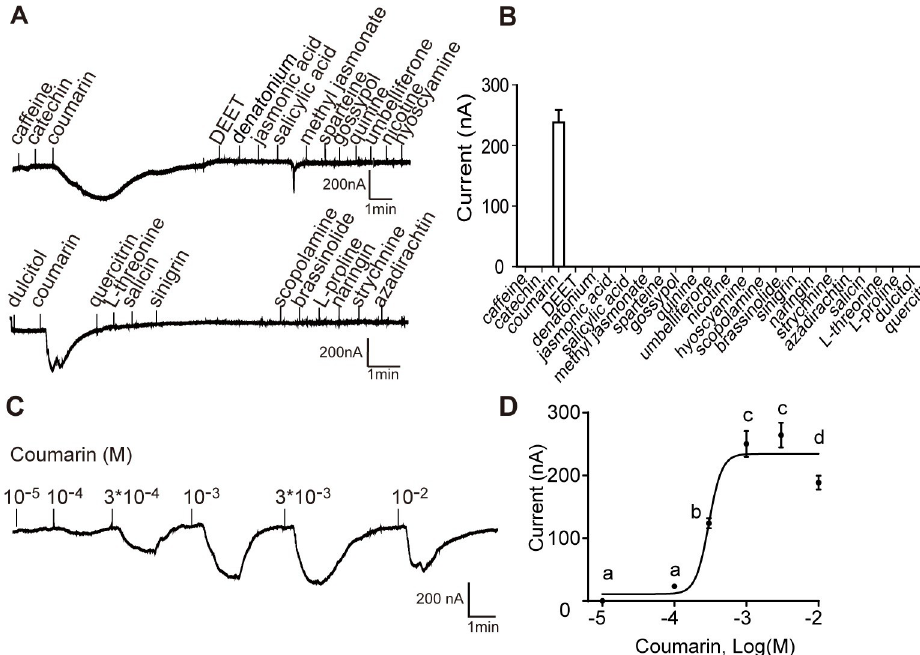
Fig 2. Functional analysis of Helicoverpa armigera Gr180 in Xenopus oocytes. ( A ) Representative inward current responses of Xenopus oocytes expressing Gr180 in response to compounds. ( B ) Response profiles of Xenopus oocytes expressing Gr180 in response to compounds (n = 8–14). ( C ) Representative inward current responses of Xenopus oocytes expressing Gr180 in response to coumarin at a range of concentrations. ( D ) Dose responses of Xenopus oocytes expressing Gr180 to coumarin (n = 8). Data are mean ± SEM. Different letters are significantly different at p < 0.05 (one-way ANOVA followed by post-hoc analysis with Tukey’s HSD test).